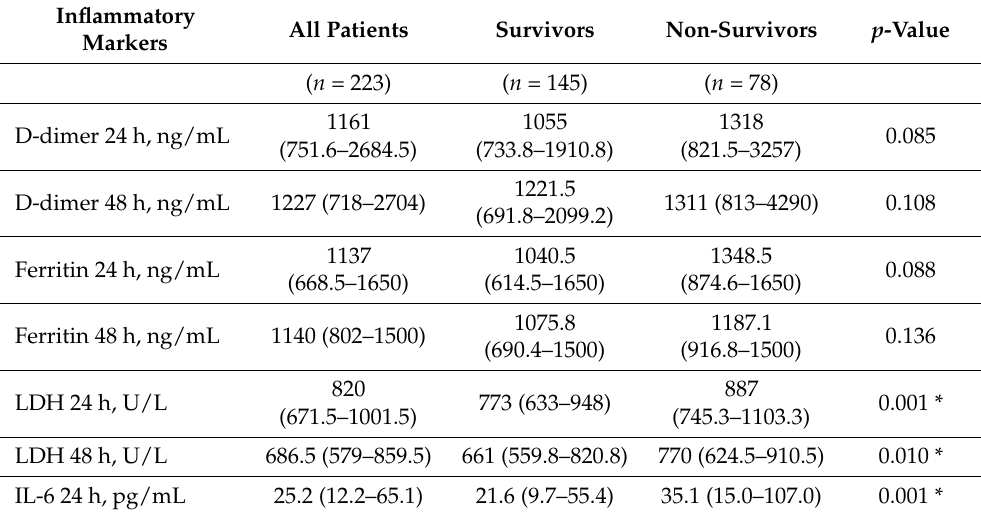
Table 2. Inflammatory markers in the overall population, as well as in survivors and non-survivors in the intensive care unit. Data are expressed as medians (1st quartile (Q1)–3rd quartile (Q3)). * Significant differences between survivors and non-survivors based on Mann–Whitney U test; LDH: lactate dehydrogenase; IL-6: